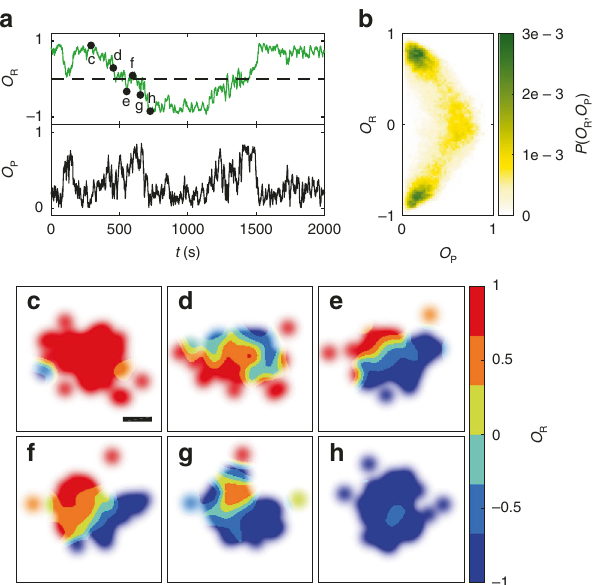
Fig. 3 Spontaneous reversal of rotation direction. a Time-dependent rotational and orientational order parameters O R and O P during a spontaneous change of the swirl ’ s sense of rotation. b Histogram of the correlation between O R and O P obtained from measurements, including about 50 rotation reversals. c – h Spatially resolved rotational order parameter at different times (marked in a ). Scale bar is 30 μ m. All measurements were performed for α = 360°, R p = ∞ , Δ =